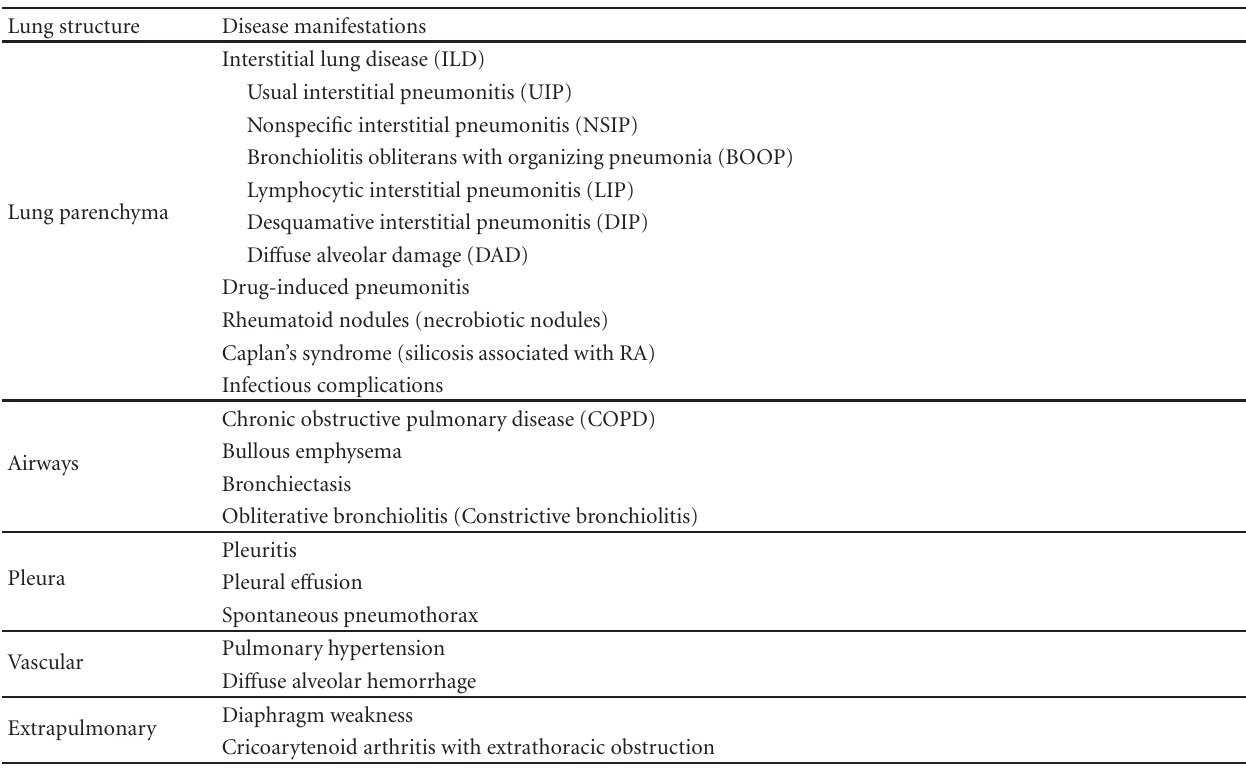
Table 1: Respiratory complications of rheumatoid